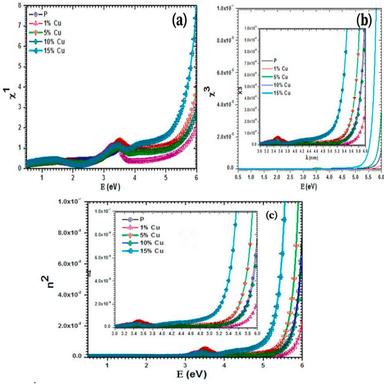
(a)–(c) χ1, χ3 and n2 plots of pure and doped films.